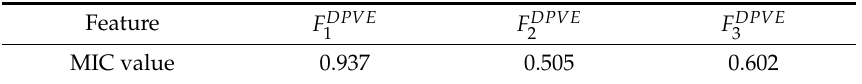
Table 3. The MIC values between the three features used for estimation and capacity values.